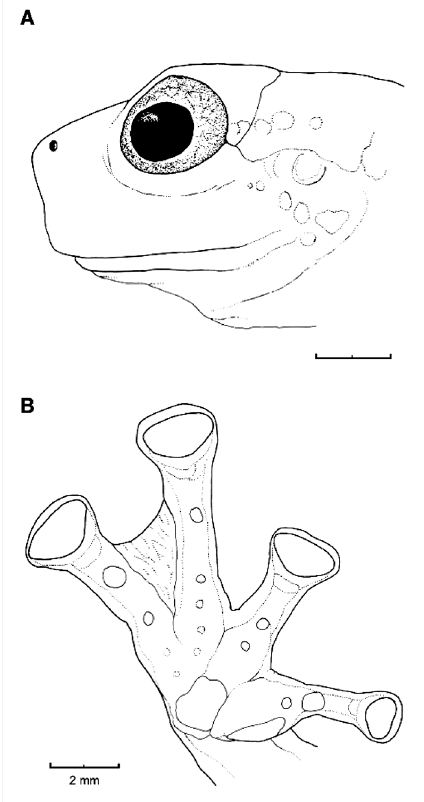
Figure 48. “Centrolene” medemi . ( A ) Head in lateral view, KU 164493. ( B ) Hand in ventral view, KU 164494. Illustrations by Juan M. Guayasamin.